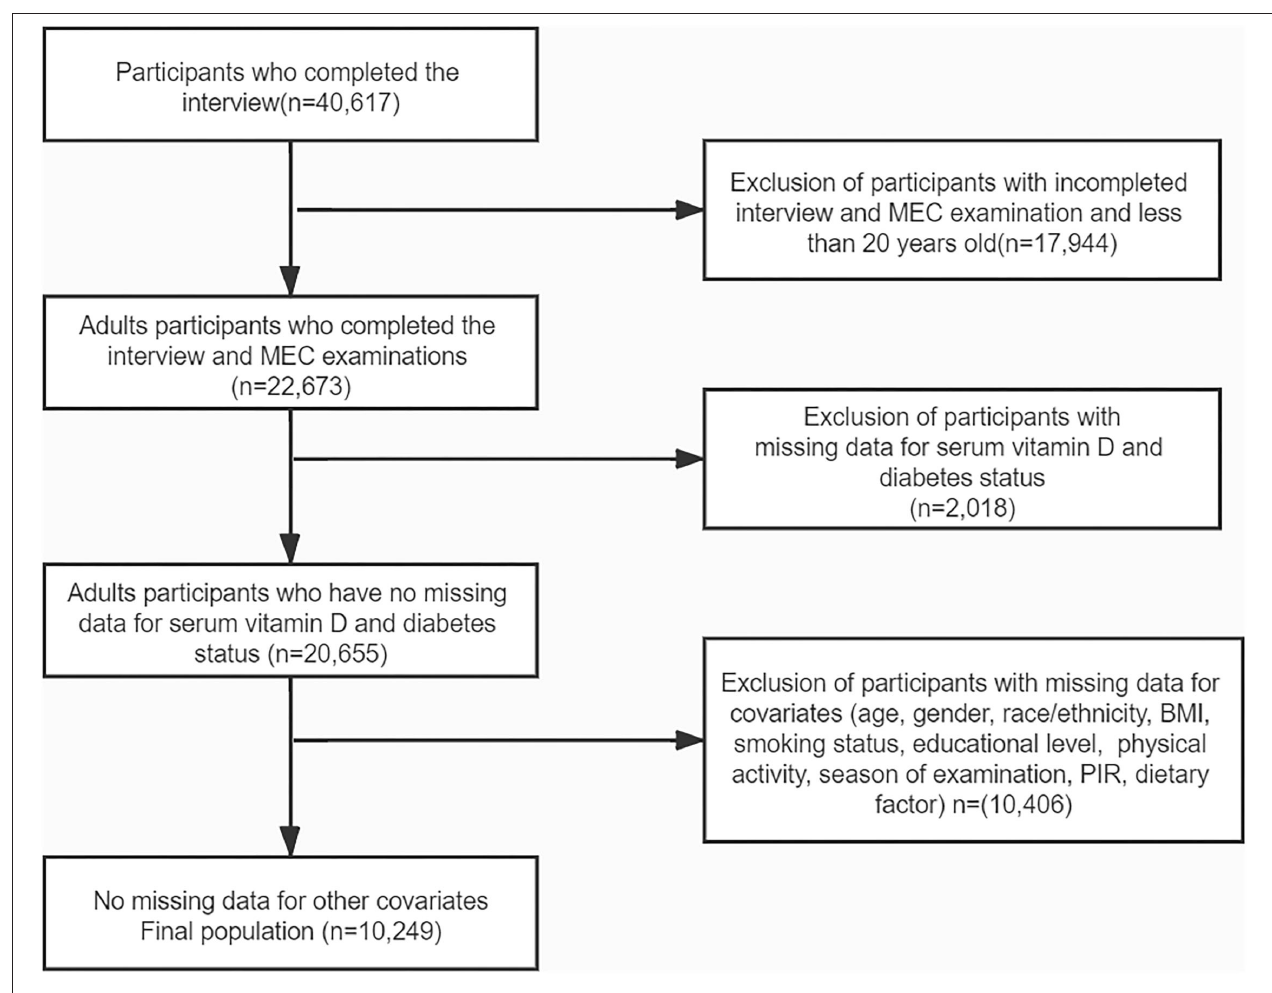
FIGURE 1 | The flow chart of the